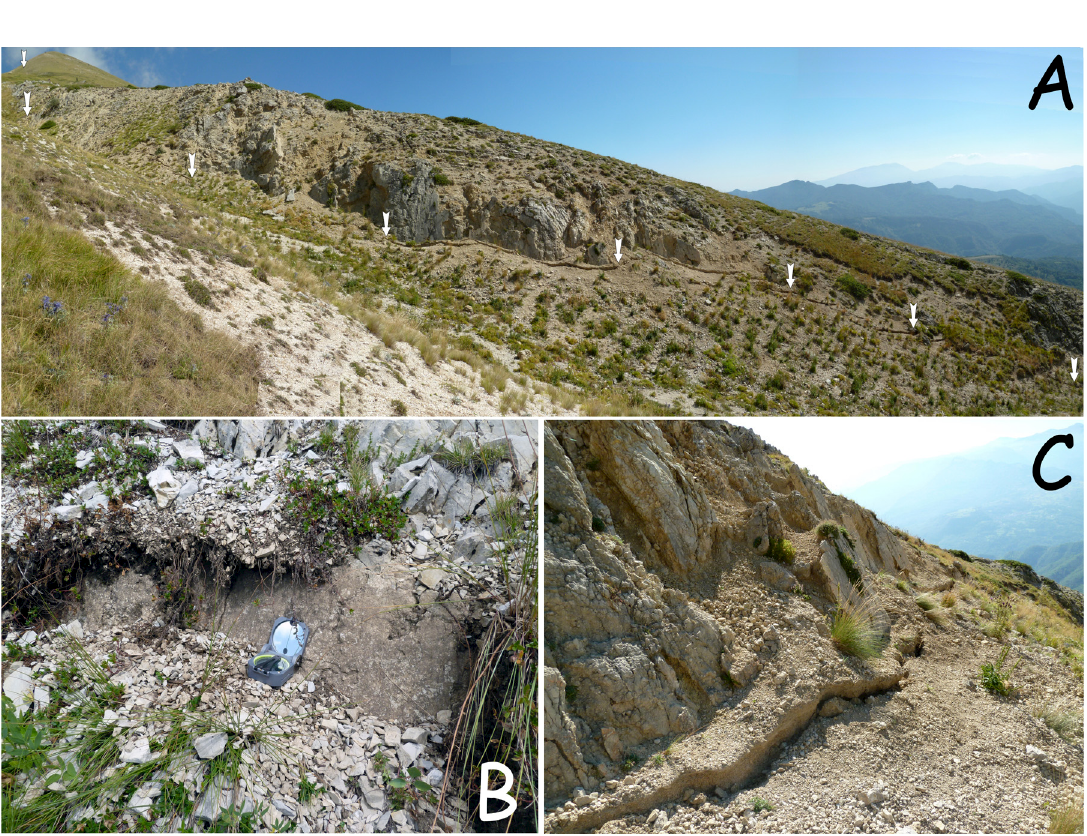
Figure 5. Pictures of the 24 August 2016 surface faulting along the Mount Vettore fault. A, southern slopes of the Mount Vettoretto segment (arrows point to the 10-30 cm step formed along the slickenside). B, faulting along the Cordone del Vettore segment. C, detail of the faulting in the mid of panel A. Surface fault- ing increased greatly after the 30 October earthquake (Mw 6.5), reaching also 2 m of